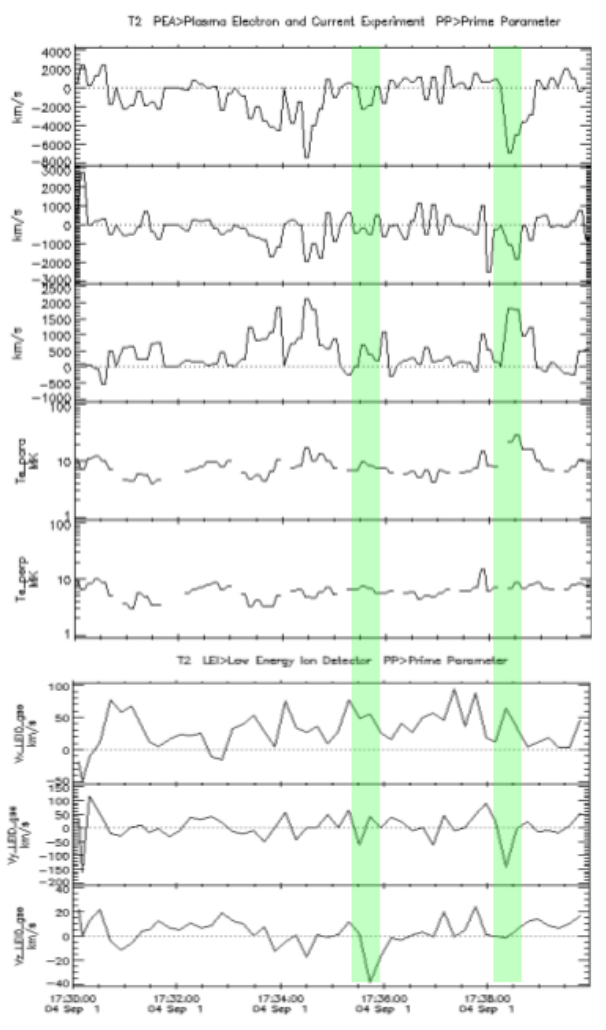
Fig. 4. Low-energy electron data recorded by PEACE on 1 September, 2004 are, from top to bottom/top panel: electron velocity, X-component ( V X ), Y-component ( V Y ), Z-component ( V Z ), the parallel electron temperature ( T para ), and the perpendicular electron temperature ( T perp ). The bottom panel shows, from top to bottom, ion velocity X-component ( V X ), Y-component ( V Y ), and Z-component ( V Z ) recorded by LEID. The time intervals of the frames under study (Fig. 1) are shaded in green.